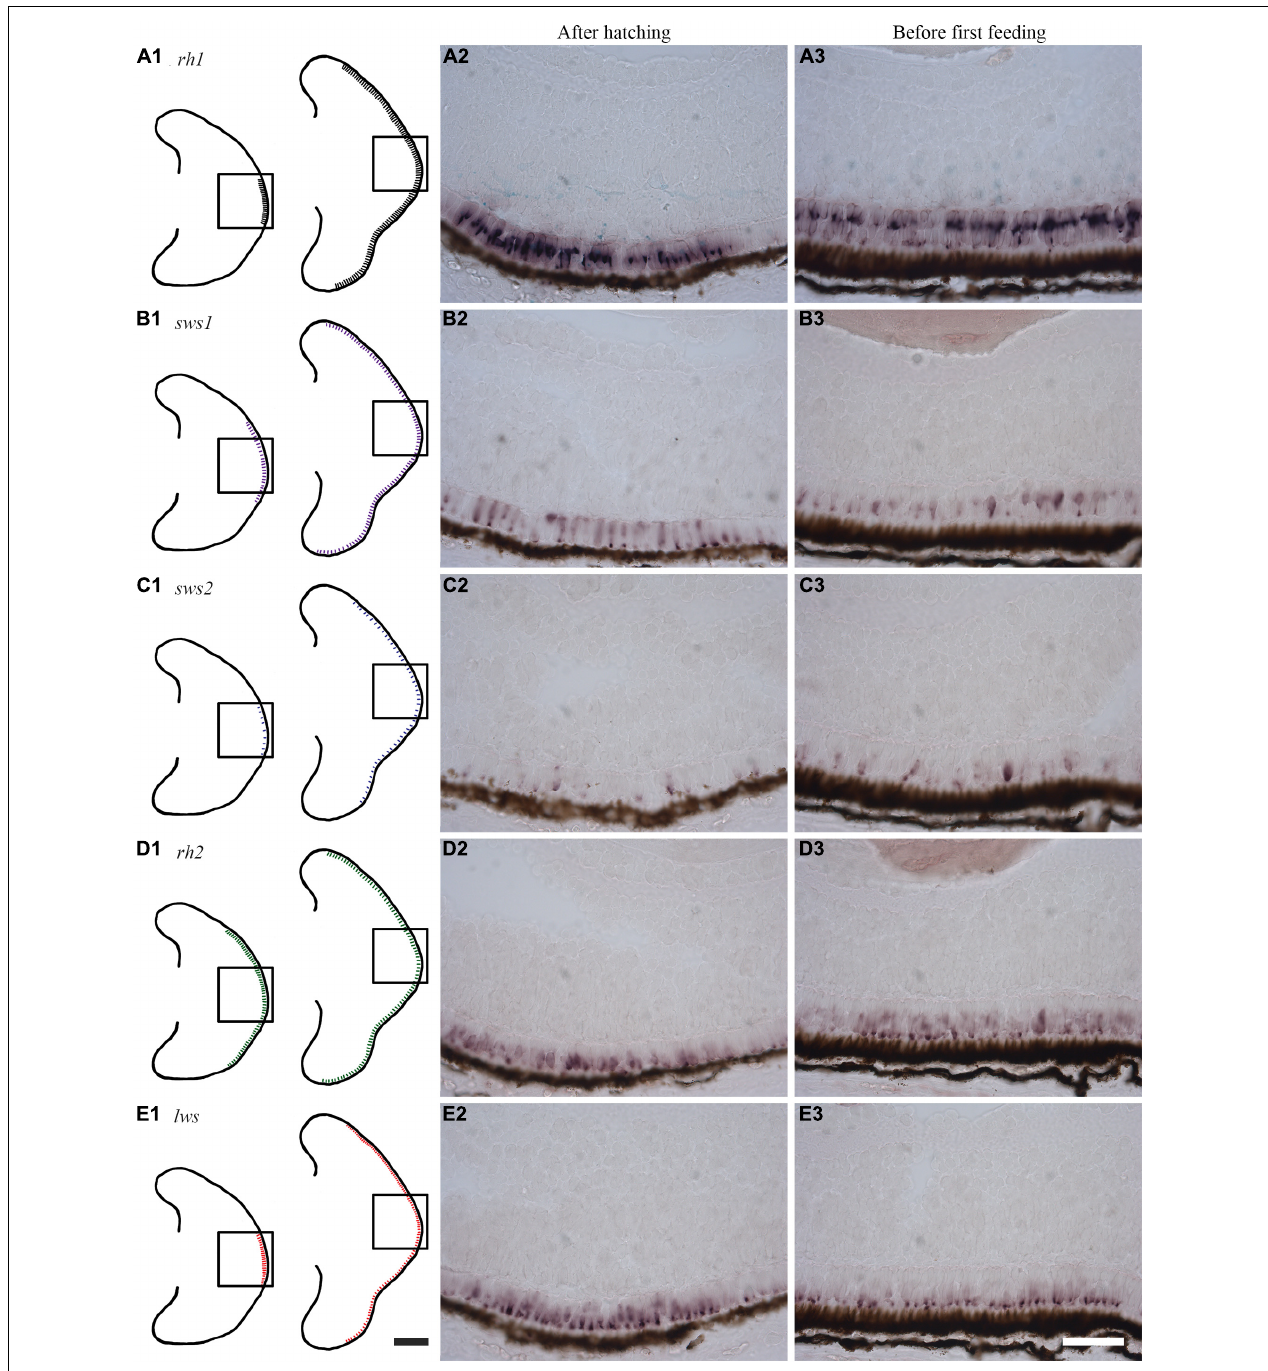
FIGURE 5 | Expression of visual opsins in the developing Atlantic salmon eye. (A1–E1) Schematics showing the expression patterns of visual opsins after hatching (555 dd) and before first feeding (720 dd) as obtained by RNA in situ hybridization. (A1–A3) After hatching, rh1 is strongly expressed in rod photoreceptor cells in the central retina, with an expression pattern that spreads dorsally and ventrally before first feeding. (B1–B3) The single cone opsin sws1 is expressed in a broader region of the central retina compared to rh1 at hatching: this expression spreads dorsally and ventrally before first feeding. (C1–C3) After hatching, the single cone opsin sws2 has scattered expression in the central retina. Before first feeding, sws2 -positive cells are sparse, but they subsequently spread dorsally and ventrally. (D1–D3) Probes detecting all four rh2 genes expressed in double cones reveal that rh2- positive cells are the most widely distributed after hatching. Before first feeding, expression levels are highest close to the retinal pigment epithelium (RPE), before spreading dorsally and ventrally. (E1–E3) Probes detecting all four lws genes (again in double cones) show a central distribution of lws before hatching. When approaching first feeding, lws expression spreads dorsally and ventrally with expression that is located towards the RPE. Scale bars, 200 µ m for schematic drawings and 50 µ m for histological sections.